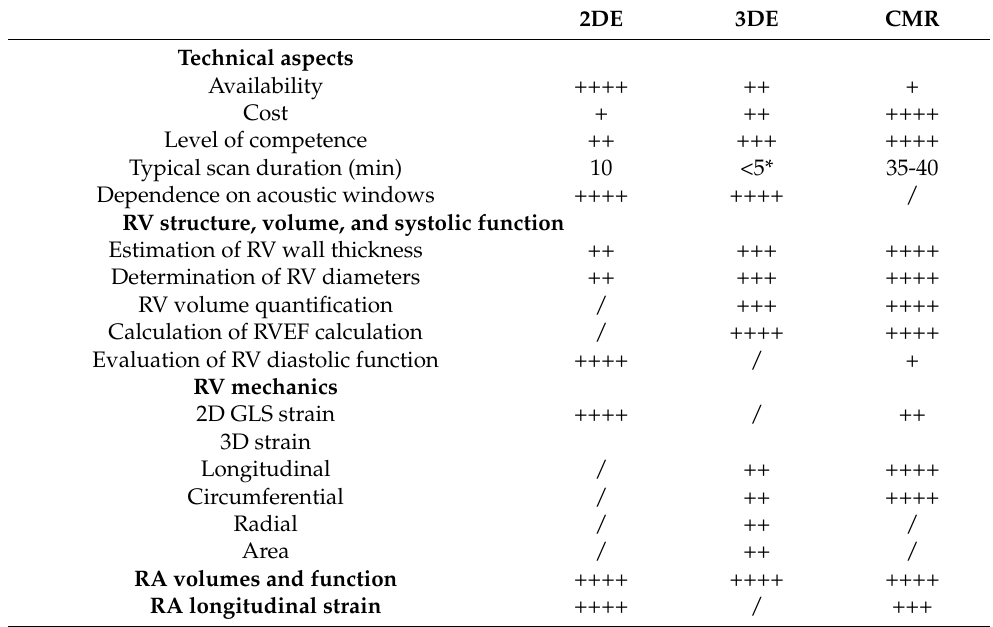
Table 1. Advantages and disadvantages of different imaging modalities in the evaluation of right ventricular and right atrial remodeling in patients with arterial